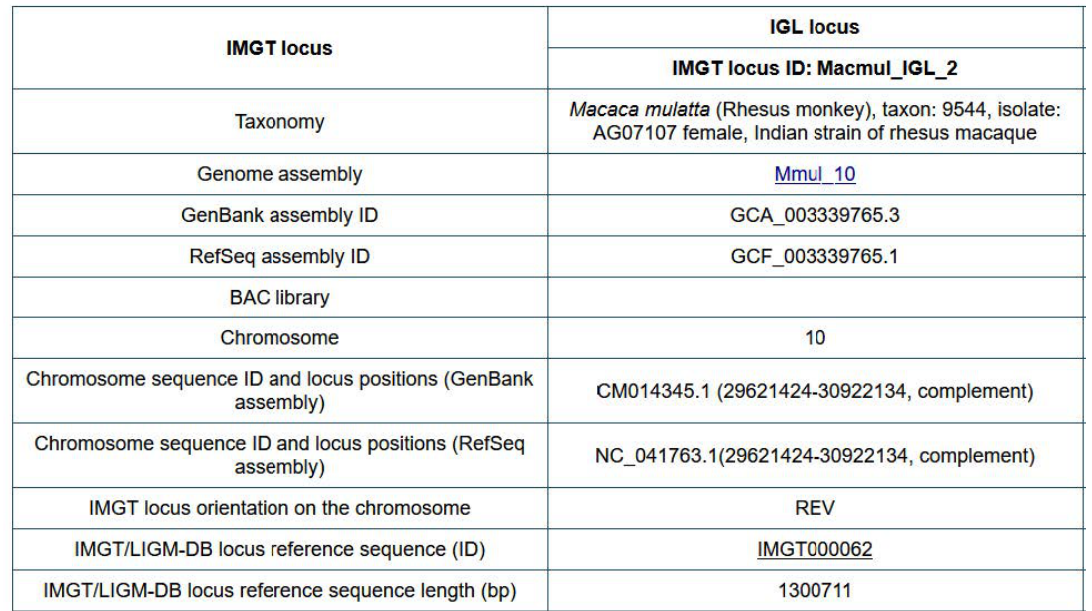
Figure 3. Locus in genome assembly: Rhesus monkey ( Macaca mulatta ) IGL IMGT ®